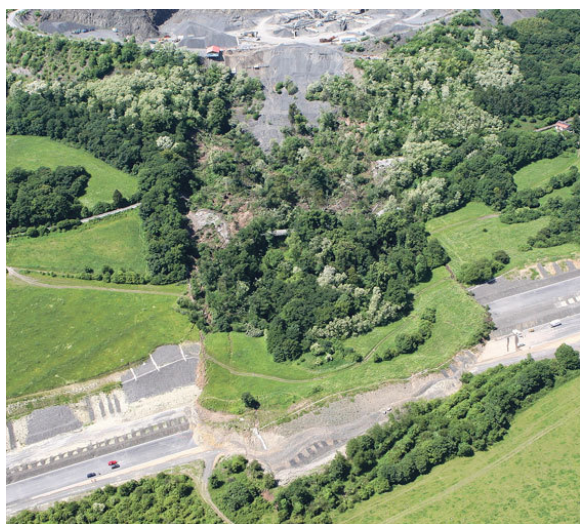
Figure 1. Picture of the landslide after collapse (summer